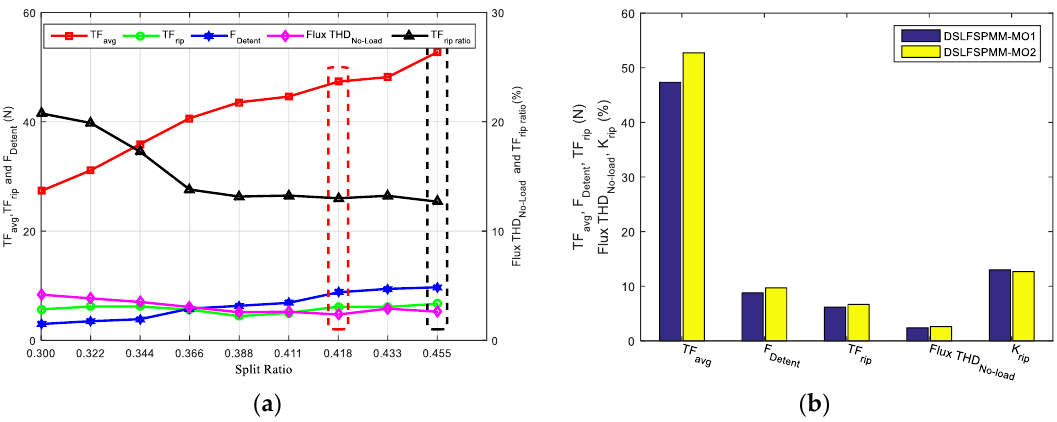
Figure 12. Split ratio optimization: ( a ) Performance comparison of DSLFSPMM-MO1 with different split ratio; ( b ) Performance comparison of DSLFSPMM-MO1 and DSLFSPMM-MO2.